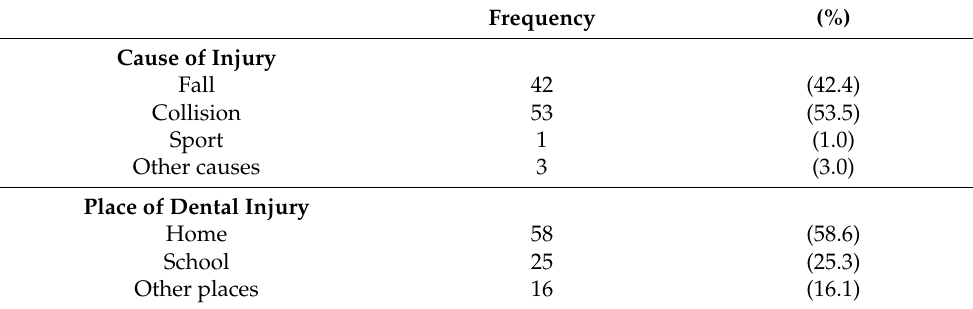
Table 3. Distribution of causes and places of dental injury among the study population.